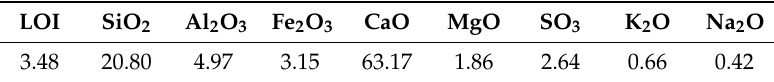
Table 1. Chemical properties of ordinary Portland cement.